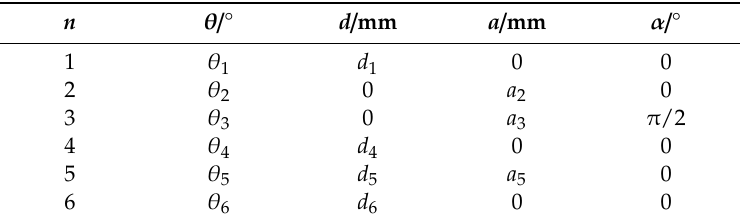
Table 2. Counter-example of Pieper Criterion 2